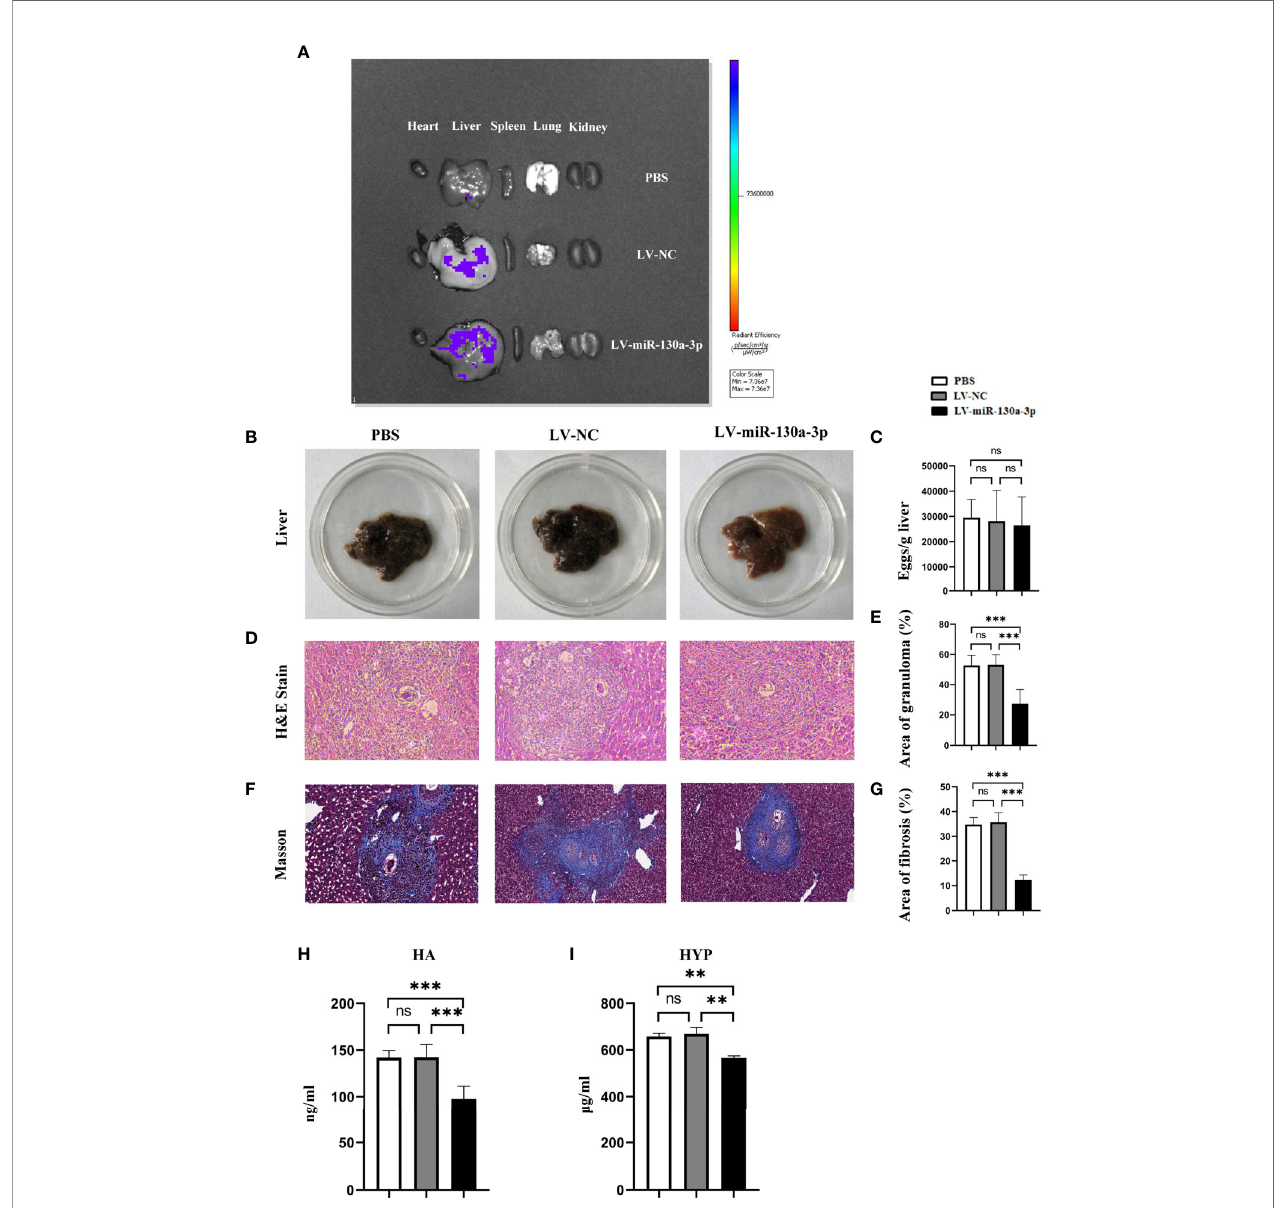
FIGURE 2 | LV-miR-130a-3p alleviated the pathological progression of liver fi brosis in S. japonicum infection. The mice were infected with 14±1 cercariae of S. japonicum through abdominal skin in different groups. We injected LV-miR130a-3p, LV-NC, or PBS into the mice through the tail vein. After 72 h, the distributions of green fl uorescent protein (GFP) in the heart, liver, spleen, lung, and kidney were detected by In Vivo Imaging System (A) . After 8weeks, the serum and the liver of different groups were collected. The photos of mice livers were captured (B) . Eggs in the liver were counted (C) . Liver tissue section was stained with H&E and the original magni fi cation of stained liver sections was 100×. The granulomas were showed with quantitative analysis (D, E) . Liver tissue section was stained with Masson, and the original magni fi cation of stained liver sections was 100×. The fi brosis was showed with quantitative analysis (F, G) . Sera HA was assayed by enzyme-linked immunosorbent assay (H) . Liver HYP was checked by the alkaline lysis method (I) . Data represent mean±SD from multigroup experiments. ** p <0.01 and *** p <0.001 (n=4 each group). ns, no signi fi